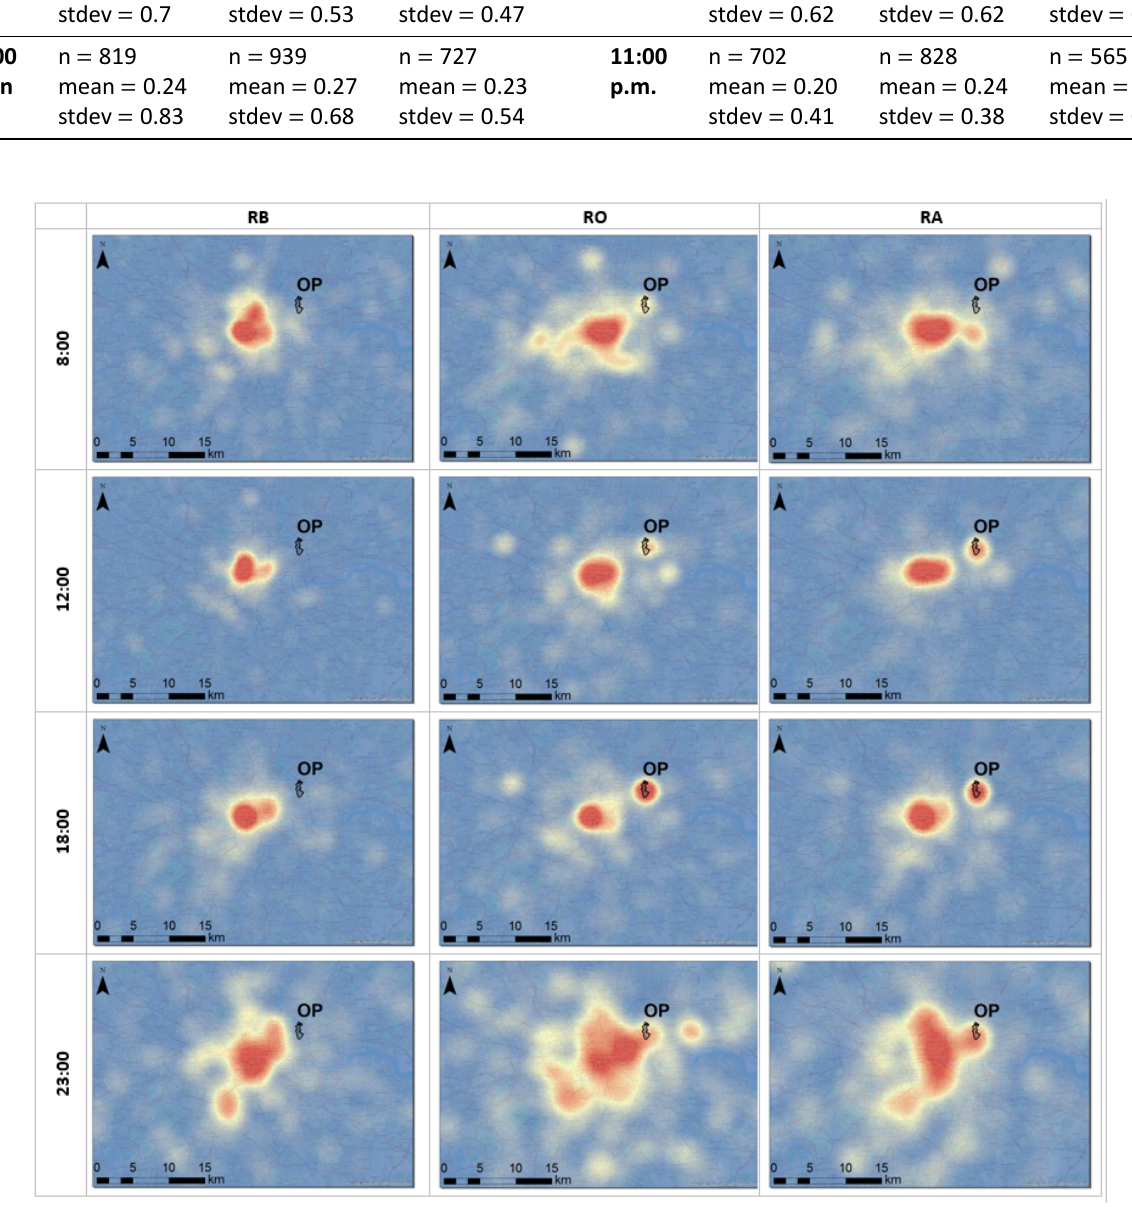
Figure 3. Hot spots of residents’ positive tweets for specific